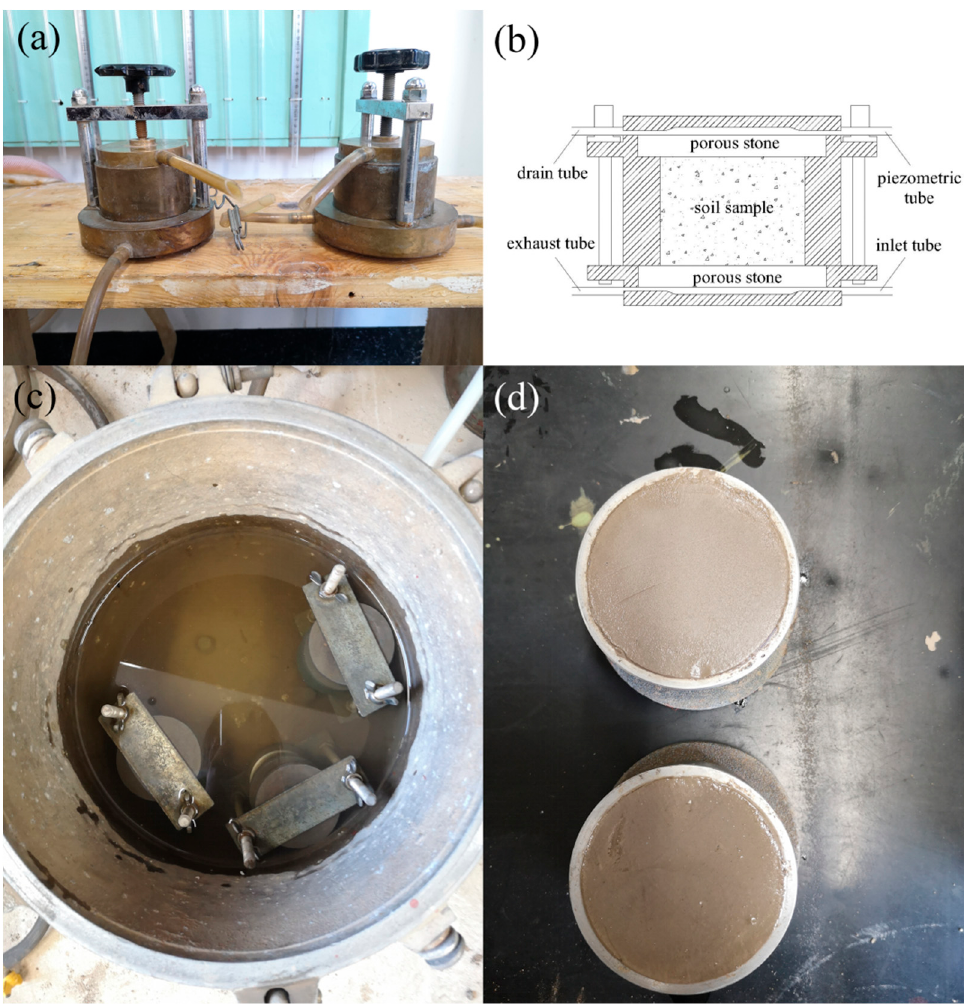
Figure 4. ( a , b ) TST-55 permeameter, ( c ) soil samples saturated in a saturator, and ( d ) soil samples after permeability testing.